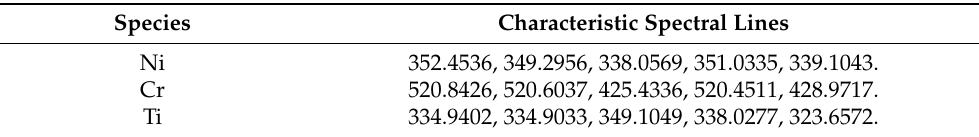
Table 3. Selection of characteristic spectral lines of Ni, Cr, and Ti by Pearson correlation coefficient.